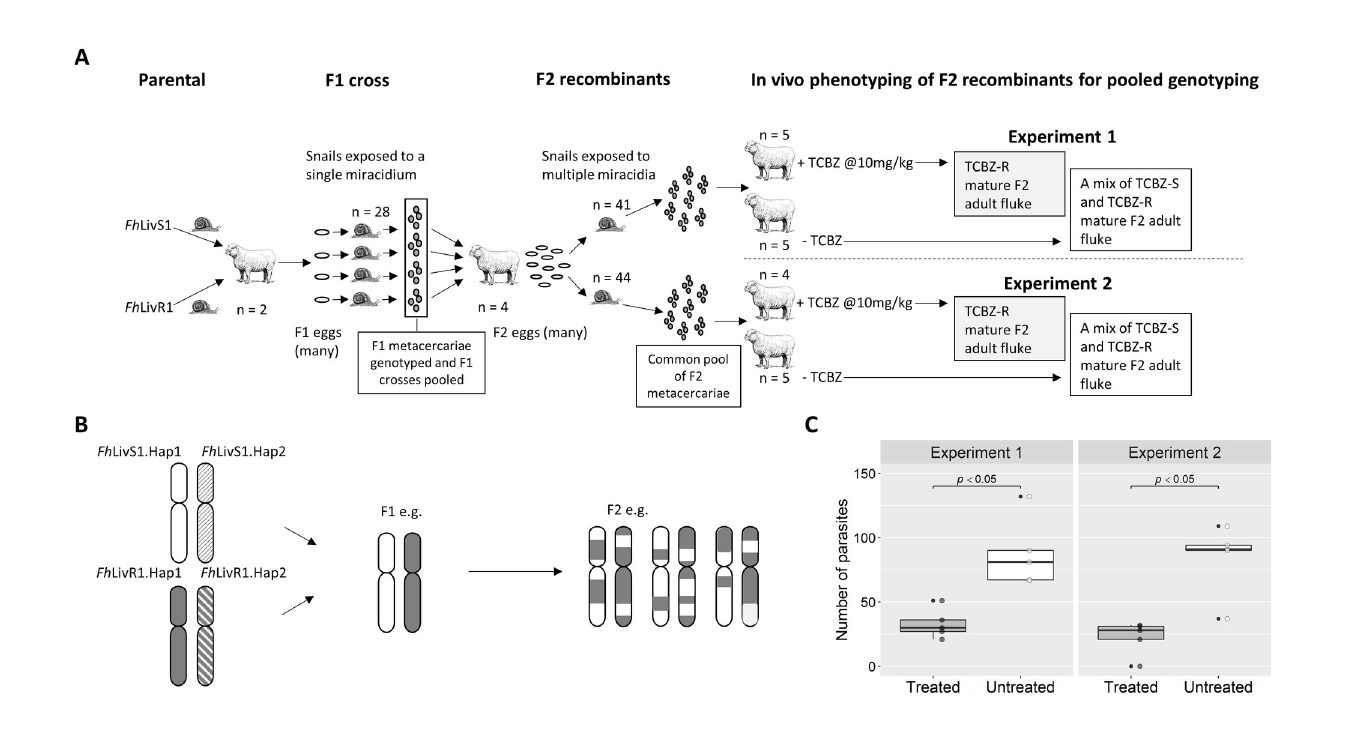
Fig 1. Experimental overview. (A) Schematic of the in vivo work to produce an F2 cross from Fh LivS1 (a clonal population of susceptible parasites) and Fh LivR1 (a clonal population of resistant parasites). The parental parasites Fh LivS1 and Fh LivR1 were produced separately and used to co-infect sheep (n = 2). Some of these parental parasites would cross-fertilise to produce an F1 cross of Fh LivS1 and Fh LivR1. Eggs were collected from the adult parasites within these sheep. A single miracidium (obtained from these eggs) was used to infect snails (n = 28) and produce clonal F1 populations. The metacercariae were genotyped to ensure they were from an F1 cross and then combined together and used to infect sheep (n = 4). Some of these F1 parasites would cross-fertilise to produce an F2 recombinant population. Eggs were collected from the adult parasites within these sheep. Snails (n = 41 and n = 44 for Experiment 1 and 2, respectively) were exposed to multiple miracidia obtained from these eggs and combined to produce a common pool of F2 metacercariae. For each experiment, two groups of animals were infected with metacercariae from this common pool. Once the infection had reached patency, one group of animals in each experiment was treated with triclabendazole (TCBZ) at a dose of 10mg/kg. At post mortem, those animals which received no treatment had a mixture of triclabendazole susceptible (TCBZ-S) and triclabendazole resistant (TCBZ-R) parasites, whilst those animals that were treated had only TCBZ-R parasites remaining. These parasites were then used for pooled genotyping. (B) A haplotype schematic to show the genetic principle behind the in vivo F2 cross. The F1 cross consists of one haplotype from the susceptible parent: Fh LivS1 ( Fh LivS1.Hap1 or Fh LivS1.Hap2) and one haplotype from the resistant parent: Fh LivR1 ( Fh LivR1.Hap1 or Fh LivR1.Hap2). In the subsequent F2 generation, recombination events take place and the resistant haplotype becomes introgressed amongst the susceptible haplotype producing an F2 recombinant population for study. (C) Plot to show the reduction in the number of F2 parasites recovered from treated animals compared to untreated animals in Experiments 1 and 2. Boxplot indicates the median number of parasites, upper and lower quartiles, and outliers; overlaid points indicate the number of parasites in each animal. In both experiments a significant difference (Mann-Whitney W = 25 p < 0.05) is seen in the number of F2 parasites from untreated and treated animals.